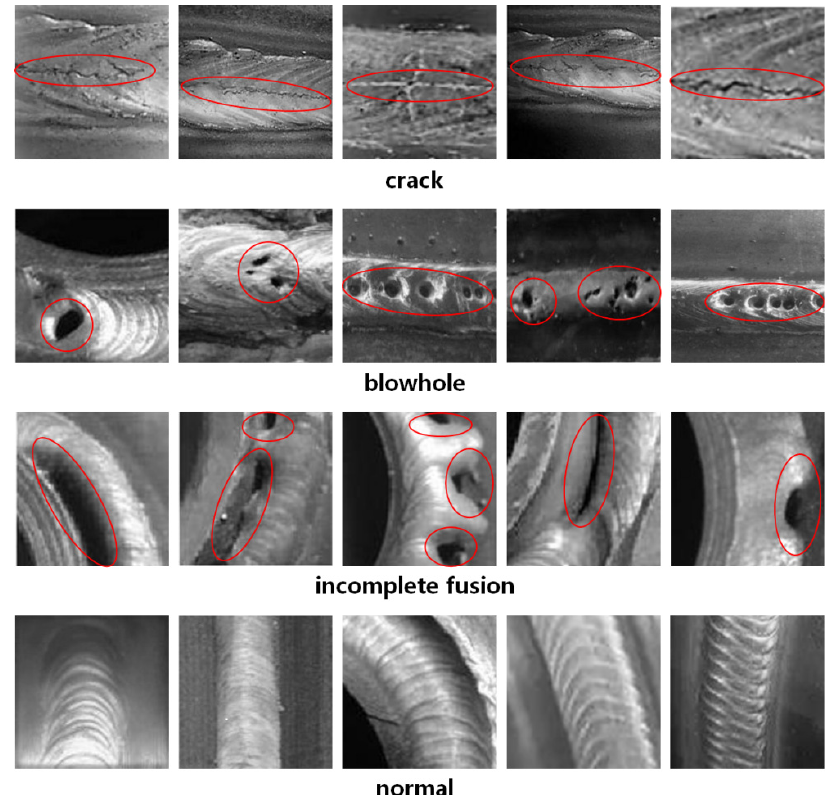
Figure 2. Sample images in the self-built dataset (partial).